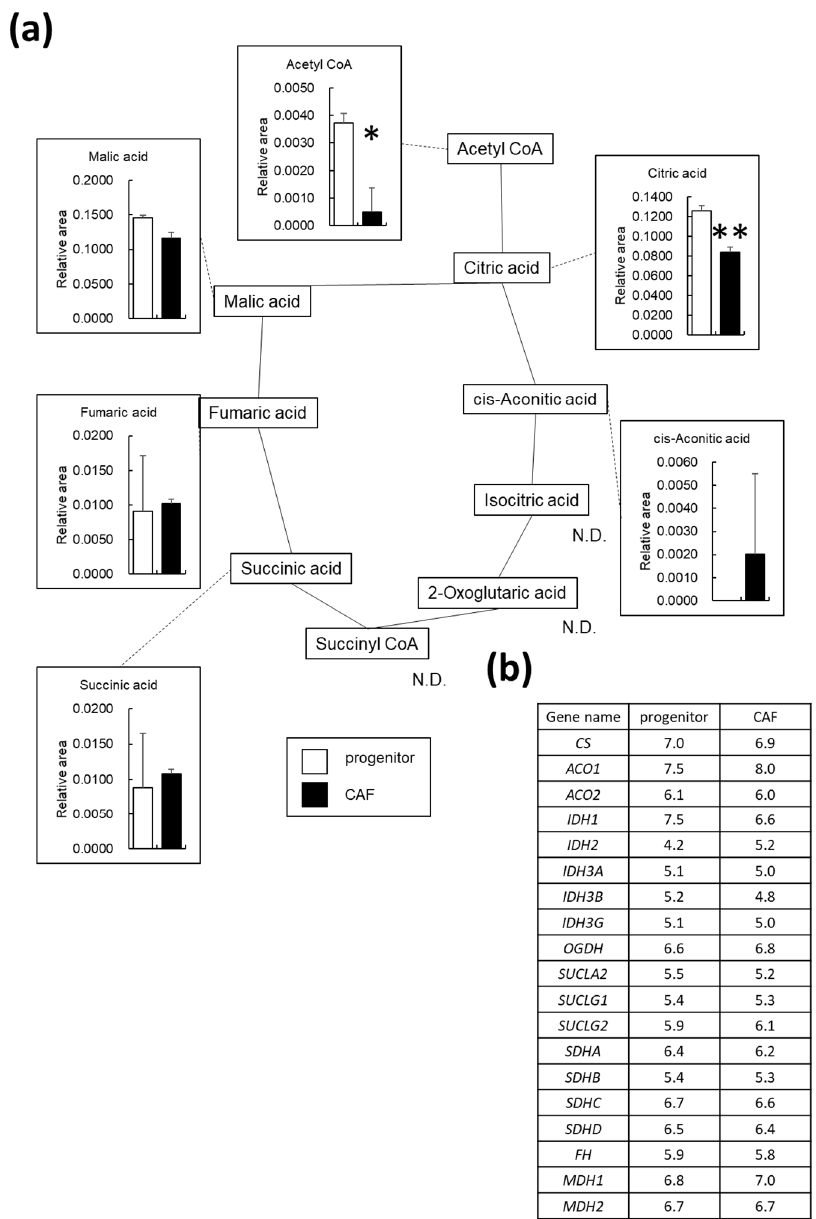
Figure 4. Changes in metabolites related to the tricarboxylic acid (TCA) cycle in the cancer-associated fibroblast (CAF) progenitors and CAFs: ( a ) Graphical representation of relative metabolite changes between CAF progenitors and CAFs, as determined by capillary electrophoresis time-of-flight mass spectrometry. N.D. indicates not detected. ** p < 0.01, * p < 0.05; ( b ) List of genes involved in the TCA cycle and their expression levels. Log2 normalized counts per million values. Asterisks (*) indicate differentially expressed